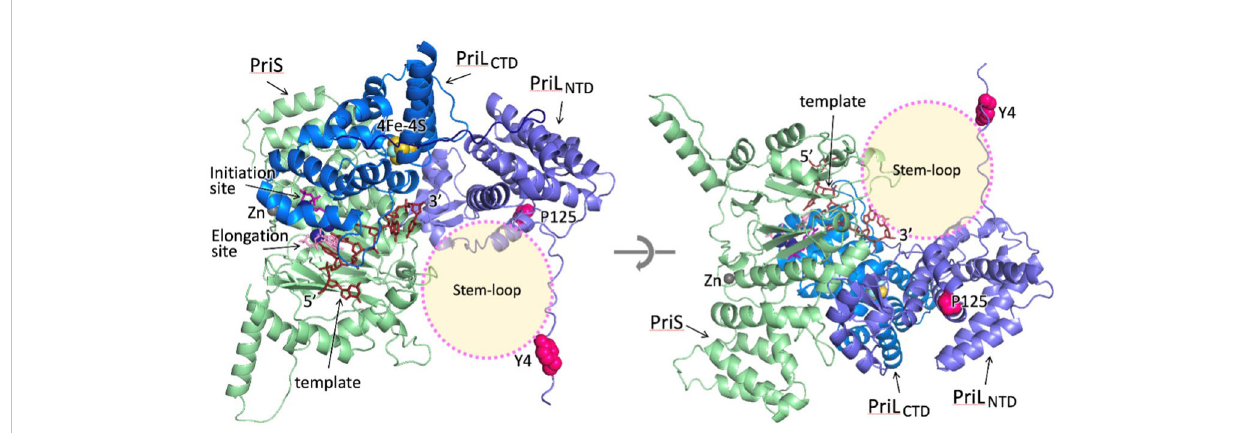
FIGURE 3 The model of the melon primase initiation complex. For clarity, two different views from opposite directions are shown. The potential stem-loop docking site is indicated by a transparent circle. The two amino acid substitutions in PriL in the resistant melon (Tyr4 and Pro125) are shown as circles in